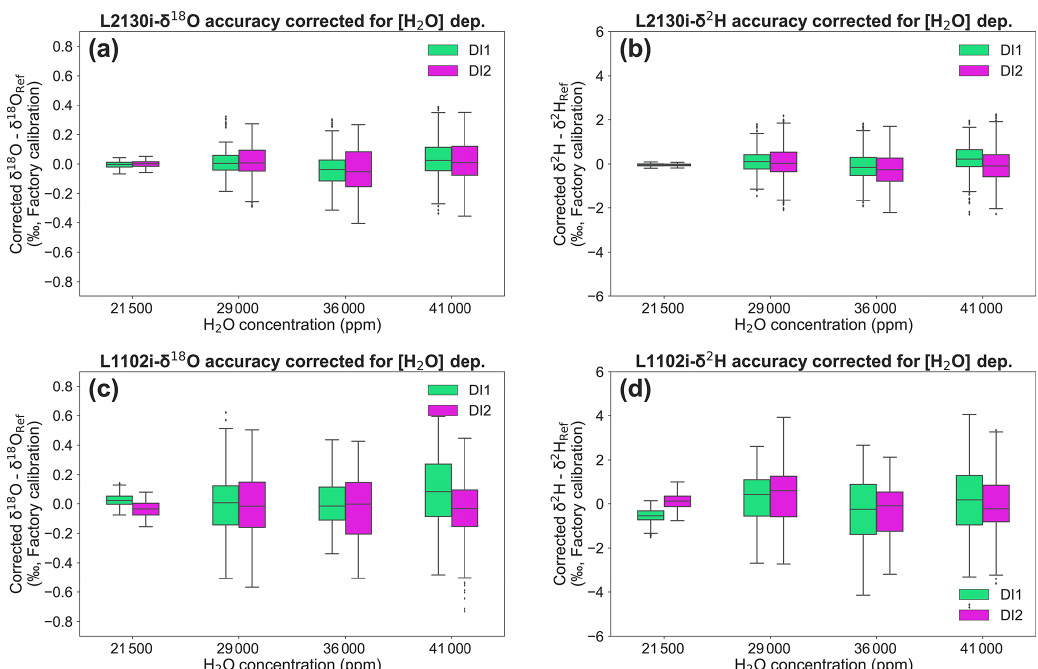
Figure 8. Deviations of δ 18 O and δ 2 H, both corrected for [H 2 O] dependence, for each standard water (DI1 and DI2) at four different H 2 O concentrations. Box plots of (a) δ 18 O and (b) δ 2 H deviations, corrected for [H 2 O] dependence of L2130i. Box plots of (c) δ 18 O and (d) δ 2 H deviations, corrected for [H 2 O] dependence of L1102i. The [H 2 O] dependence of each CRDS analysers was corrected by the DI1–2*2Pairs calibration strategy with the best fitting methods (L2130i- δ 18 O: linear fitting, L2130i- δ 2 H: quadratic fitting, L1102i- δ 18 O: cubic fitting, L1102i- δ 2 H: linear surface fitting) at a 168h